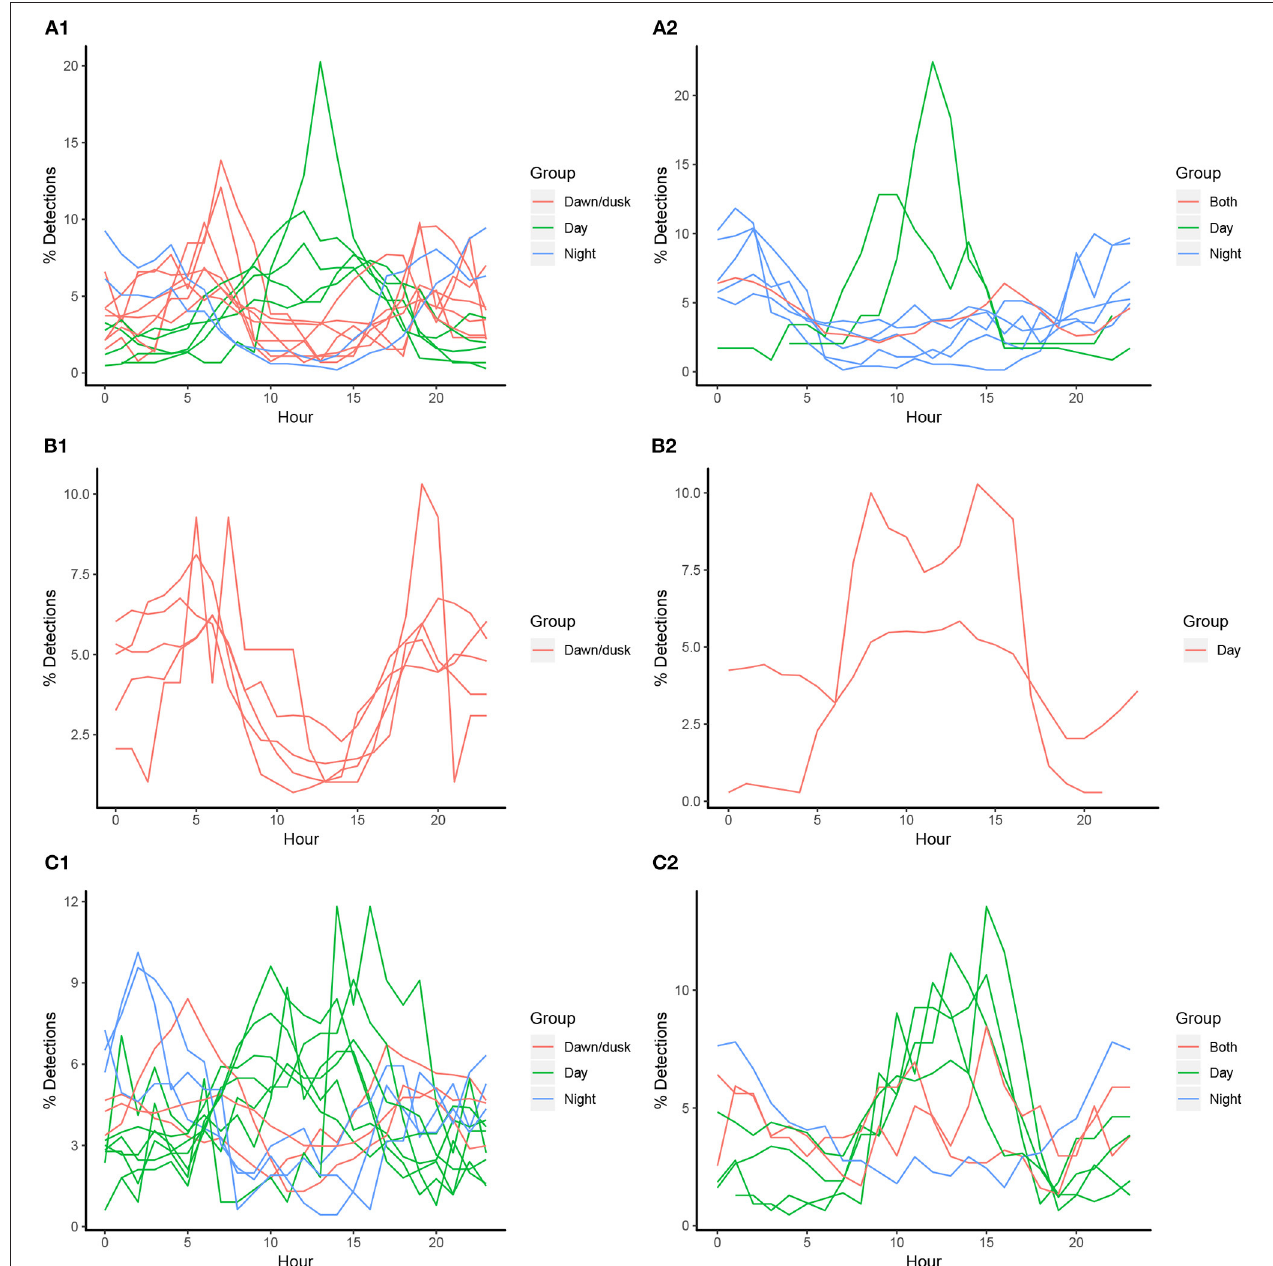
FIGURE 3 | Individual proportions of hourly detections in St. Joseph Atoll for acoustically tagged P. ater (A) , U. granulatus (B) , and U. asperrimus (C) . Figures on the left represent detections in the reef flat habitat (A1,B1,C1) and figures on the right represent detections in the lagoon habitat (A2,B2,C2) . Colors represent when diel peaks